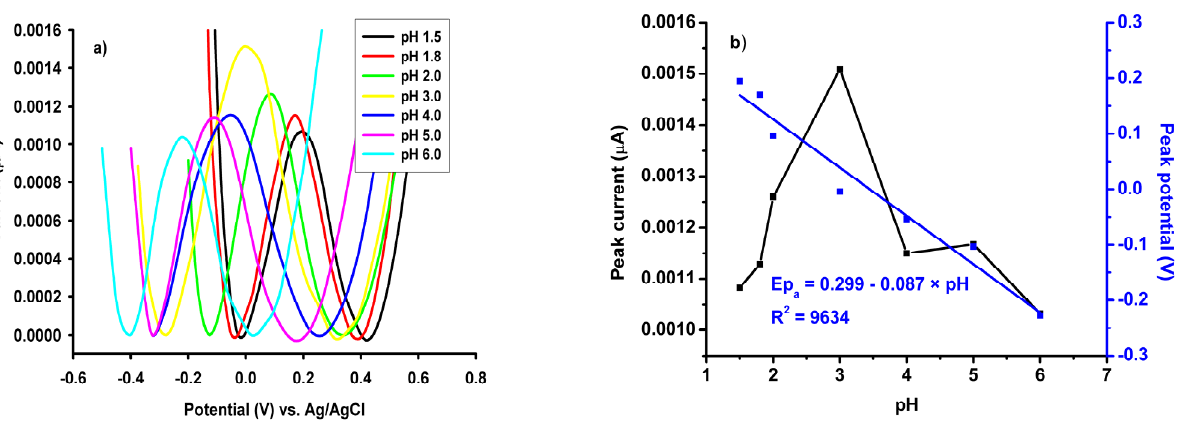
Figure 4. ( a ) Differential pulse voltammograms of 1 × 10 − 4 mol L − 1 R-limonene using the TPP/AuNPs- S-Gr sensor in PBS at pH values of 1.5, 1.8, 2.0, 3.0, 4.0, 5.0, and 6.0. ( b ) The effect of the pH on the peak current (black dots) and the linear dependence of the peak potential with the pH (blue line). In the case of the Fe(TPFPP)Cl/AuNPs-S-Gr sensor, the peak current increased from pH 1.5 to pH 3.0, which is the maximum value (Figure 5). Then, a decrease in pH to 6.0 was recorded (Figure 5).